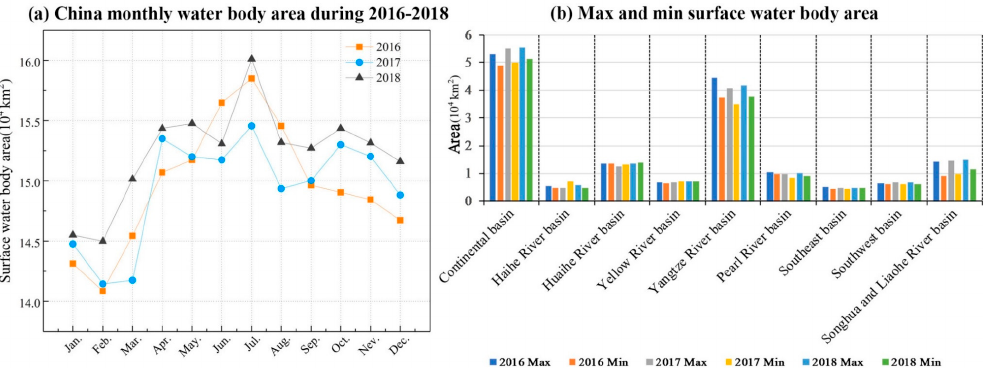
Figure 5. ( a ) Monthly changes in China water area during the period of 2016–2018, ( b ) the max and min surface water body area (10 4 km 2 ) of each basin during 2016–2018. The boundary of basins comes from the Institute of Geographical Sciences and Natural Resources Research, Chinese Academy of